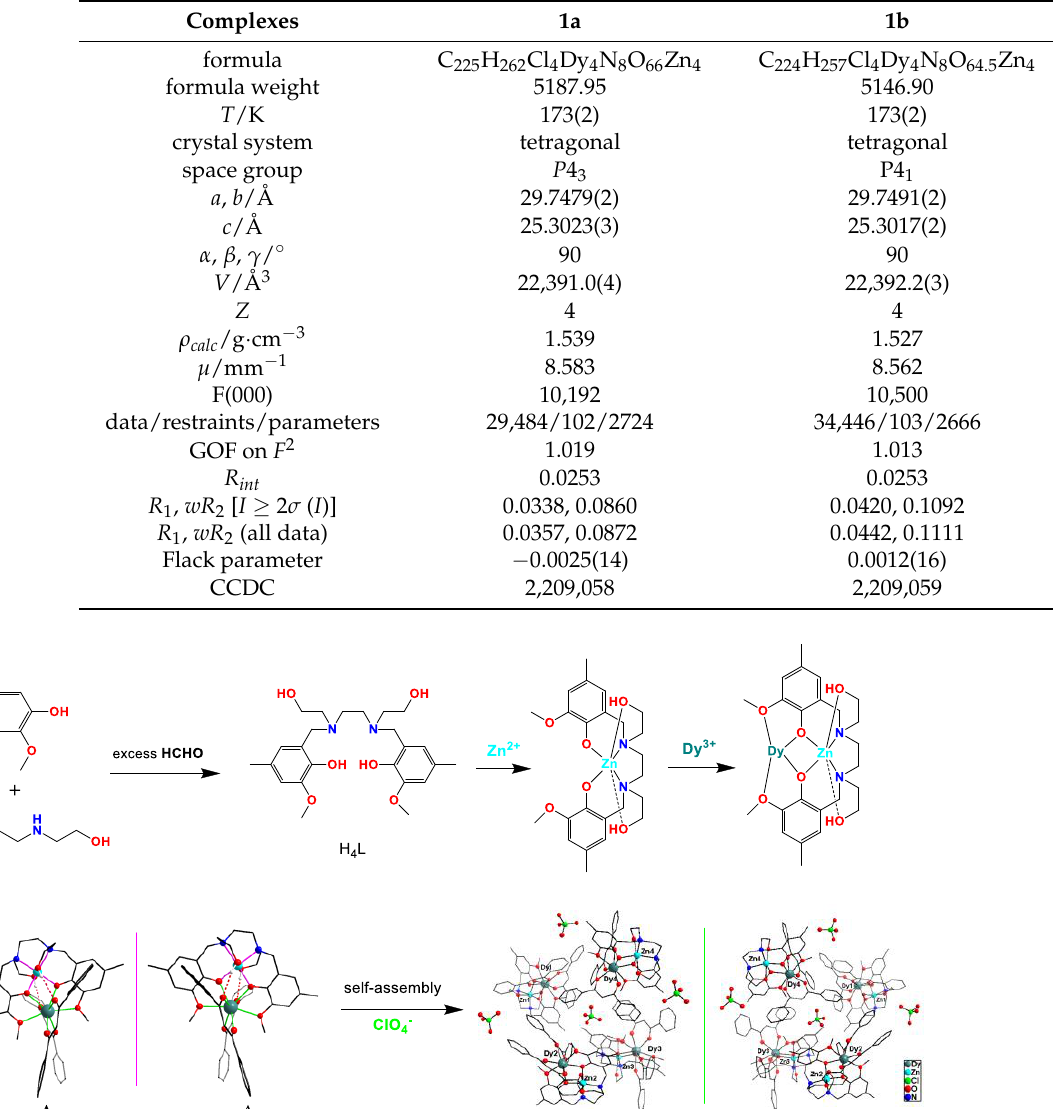
Table 1. Crystal data for complexes 1a and 1b .